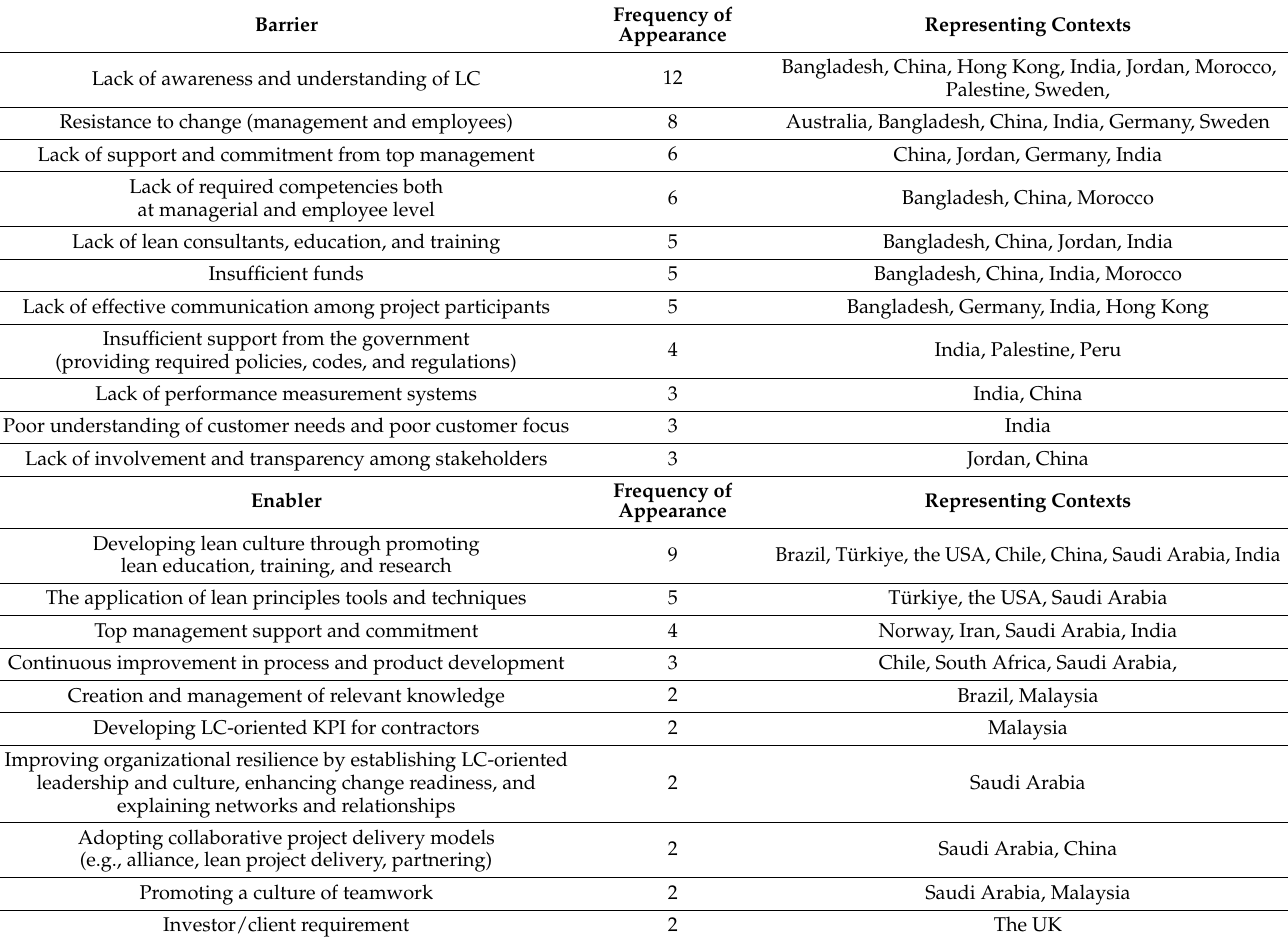
Table 1. Barriers and enablers of implementing lean construction.